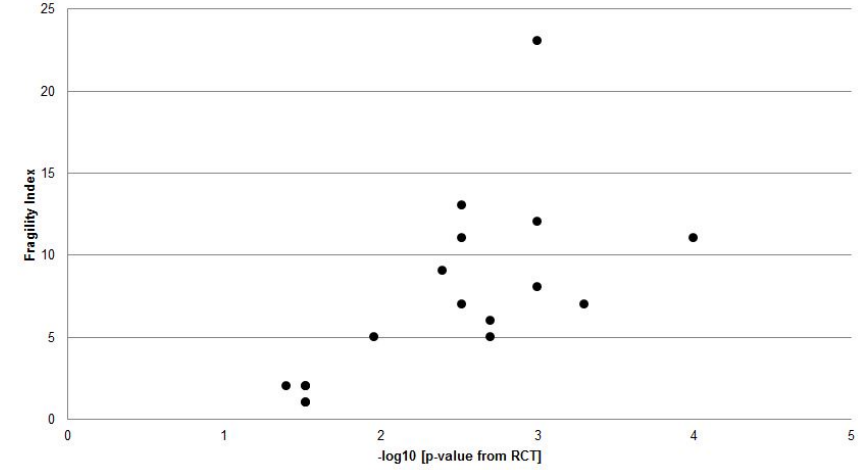
Figure 3. Correlation between negative Log RCT p ‐ value for primary outcome and calculated Fragility Index ( r = 0.700, p = 0.002).